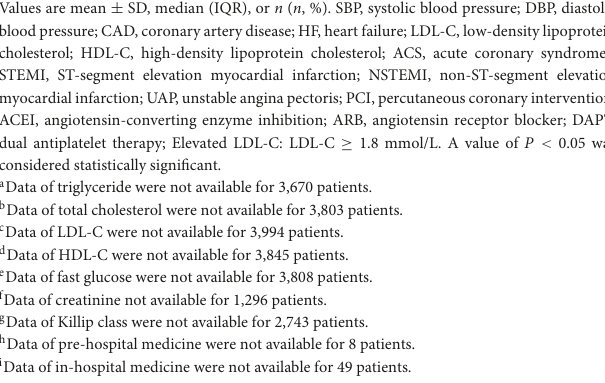
mean ± standard deviation (SD) or median (IQR), and categorical variables were presented by counts and percentages. Continuous variables between two groups were compared by the two-sided t-test or the Mann–Whitney U test according to the normality of the distribution. Continuous variables between three or more groups were compared by an ANOVA or the Kruskal-Wallis test according to the normality of the distribution. Categorical variables were assessed with the Chi-square test. We used Cox